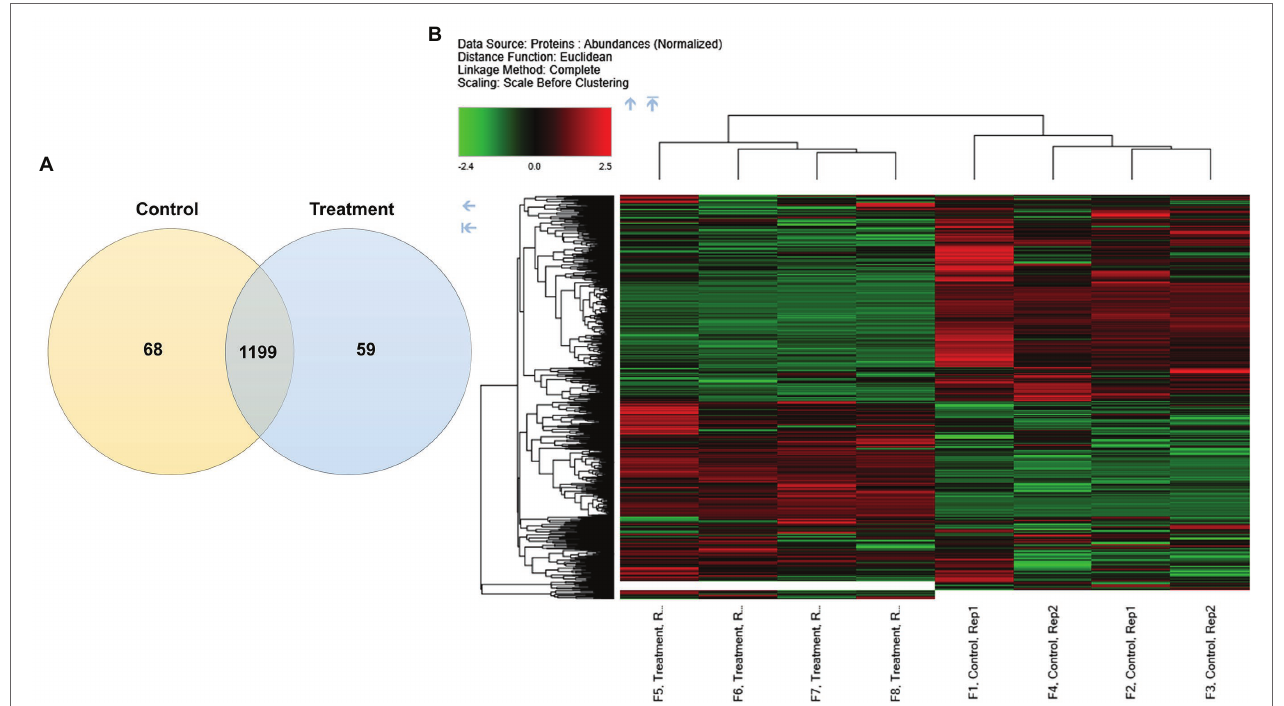
FIGURE 2 | Differential protein expression profiles in Candida albicans. (A) Venn diagram depicting numbers of unique and common proteins identified in the control and treatment groups. (B) Heatmap with hierarchical clustering of differentially expressed proteins. Color key expression: green and red represent lower and higher differential abundance,